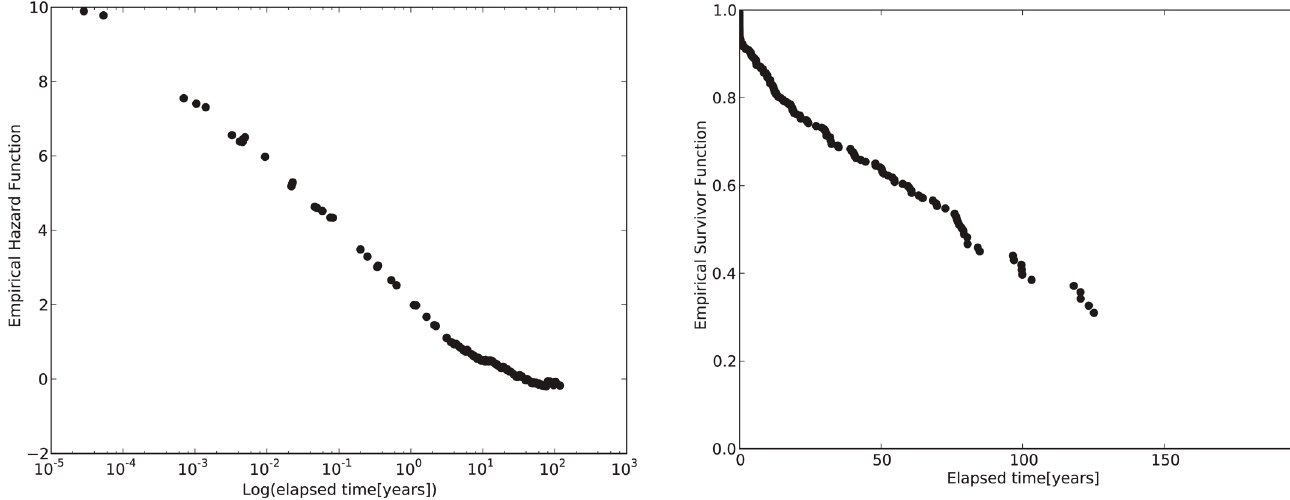
Figure 4. Empirical baseline survival function (Equation 3) for the Italian